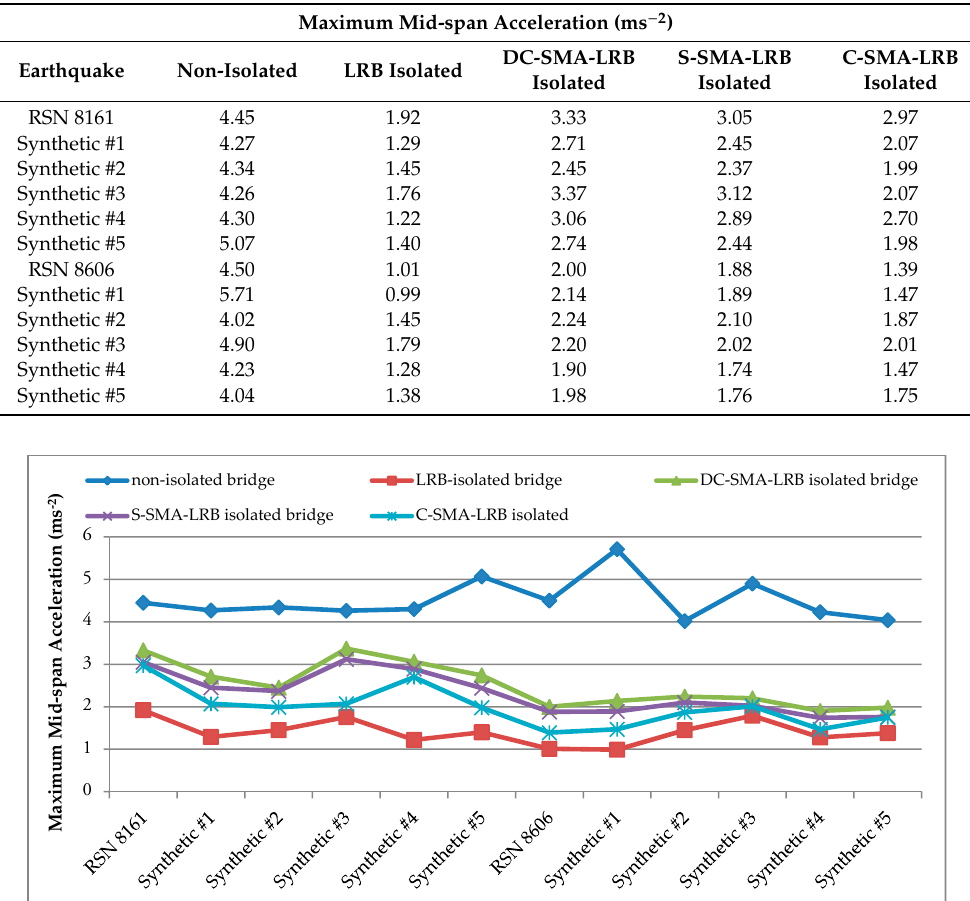
Figure 13. Graphical demonstration of the mid-span acceleration for the non-isolated, LRB-isolated and three SMA-LRB isolated bridges.